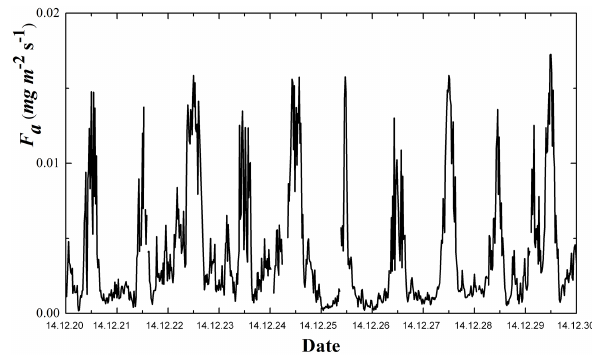
Figure 6. Temporal variations in the mass flux of aerosol observed during 20–29 December